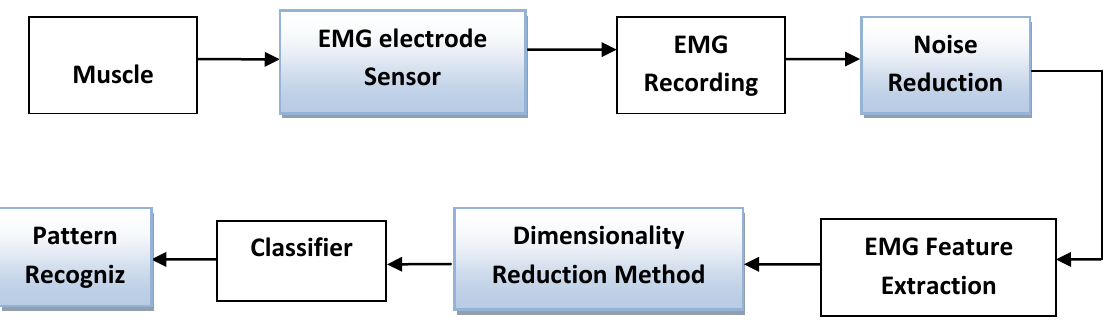
Figure 7. Block diagram of the process of EMG classification